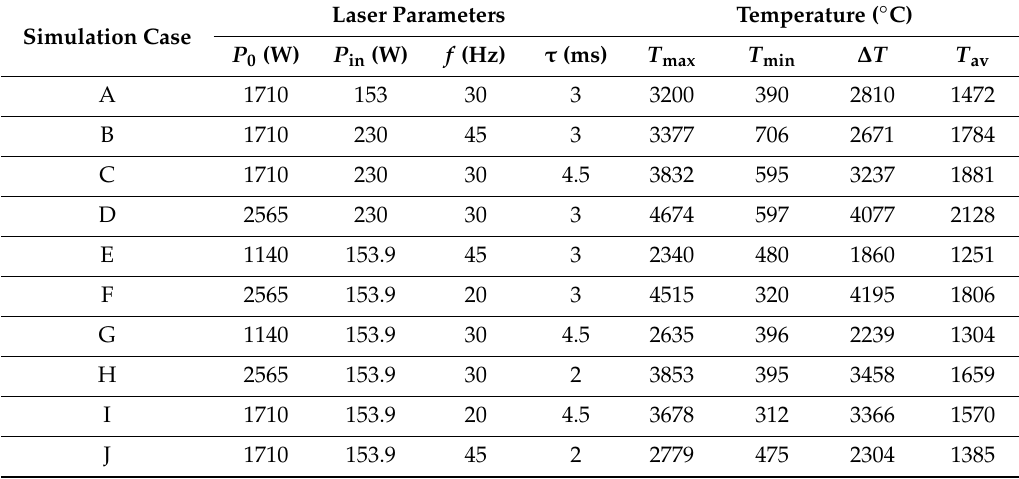
Table 1. Laser heating parameters and simulation results.